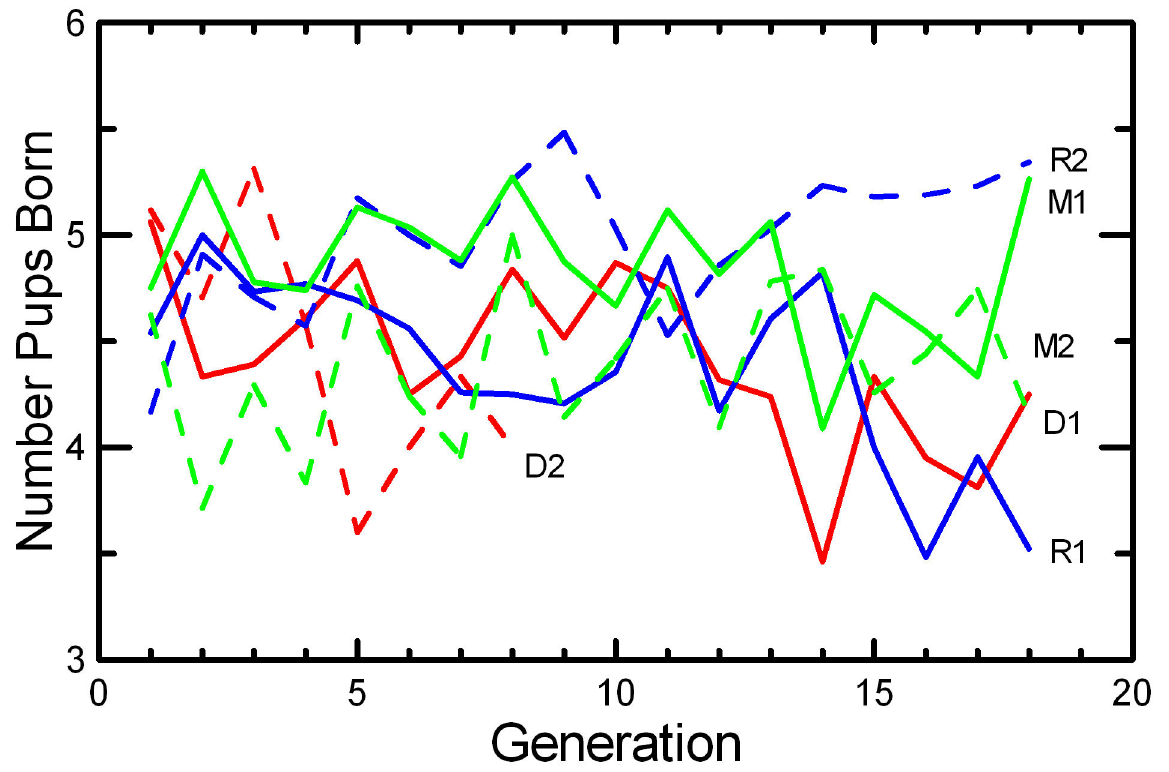
Figure 7. Mean litter size. The mean number of pups born in first and second litters is given for the two replicates of RAN (blue), MK (green), and DOC (red) experimental populations. doi: